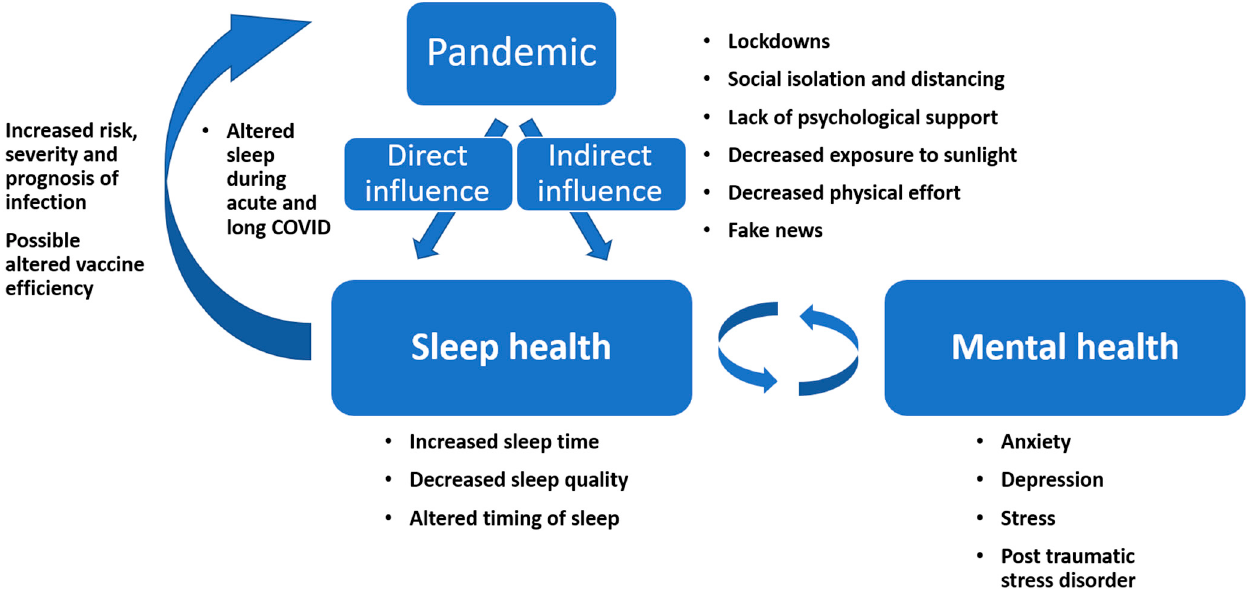
Figure 1. The bidirectional relationship between COVID-19 and sleep/mental health.